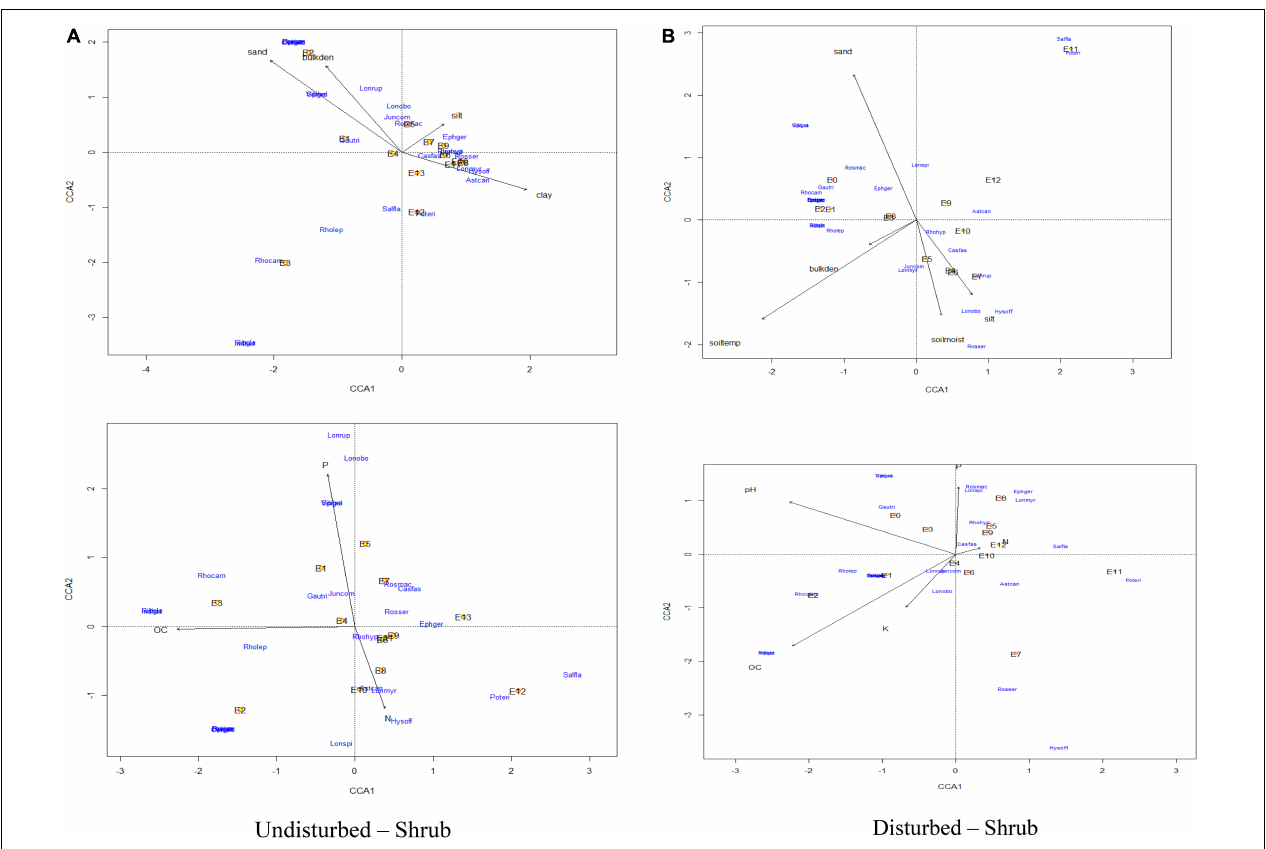
FIGURE 12 | Canonical correspondence analysis of vegetation abundance and elevation (represented by E) overlaid to soil parameters at a p.max = 0.25 for undisturbed and disturbed quadrates of shrubs in